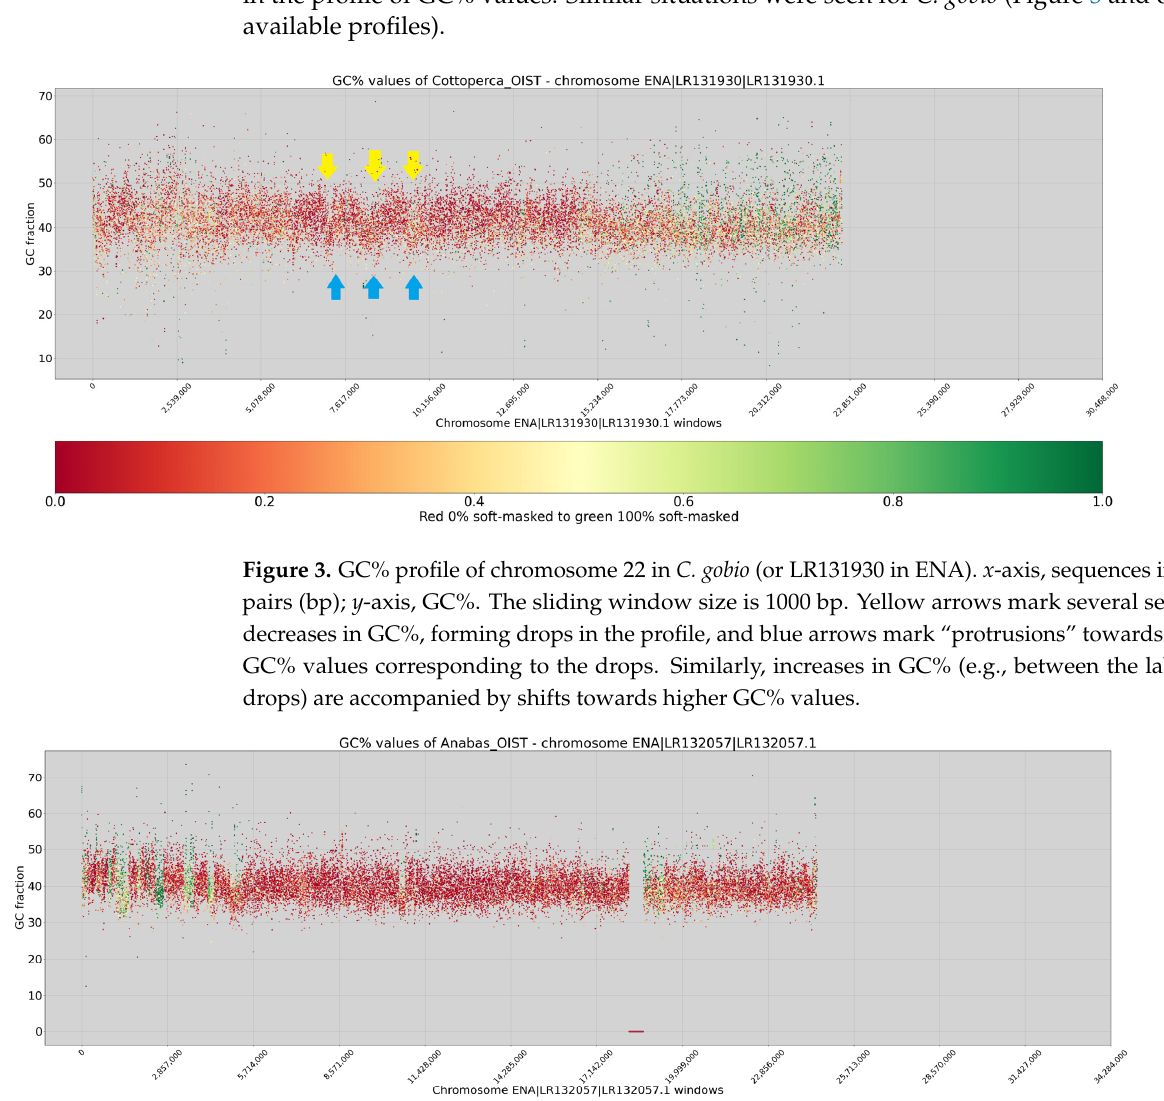
Figure 2. Overview of the two genome assemblies analysed in this study. Each chromosome ( x -axis) is represented as a dot, with the y -axis showing GC% values. Chromosomes are sorted by size, from largest to smallest. The colour gradients of the dots reflect the proportion of soft-masked sequences (rep%) with the two extremes being red, indicating unmasked, and green, indicating soft-masked regions. The colour scale below each graph represents a species-specific flexible range of the soft- masking percentage. The sliding window size is 1000 nt for both species. A putative sex chromosome (no. 18) in A. testudineus is shown demonstrating a high proportion of repeats for its size.